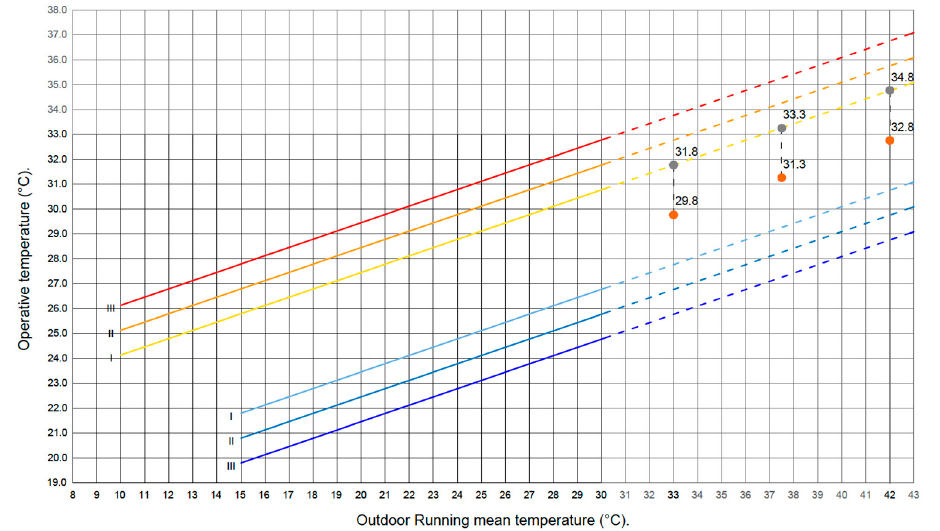
Figure 1. Adaptive Thermal Comfort graph according to the European standard EN 15251-2007 [2] ATCmean and ATCmax values for the TRs have been